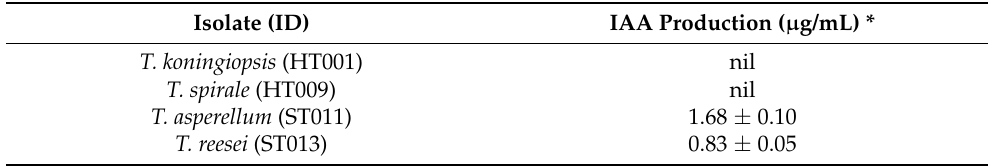
Table 9. Indole acetic acid (IAA) produced by Trichoderma isolates, T. koningiopsis HT001, T. spirale HT009, T. asperellum ST011, and T. reesei ST013.